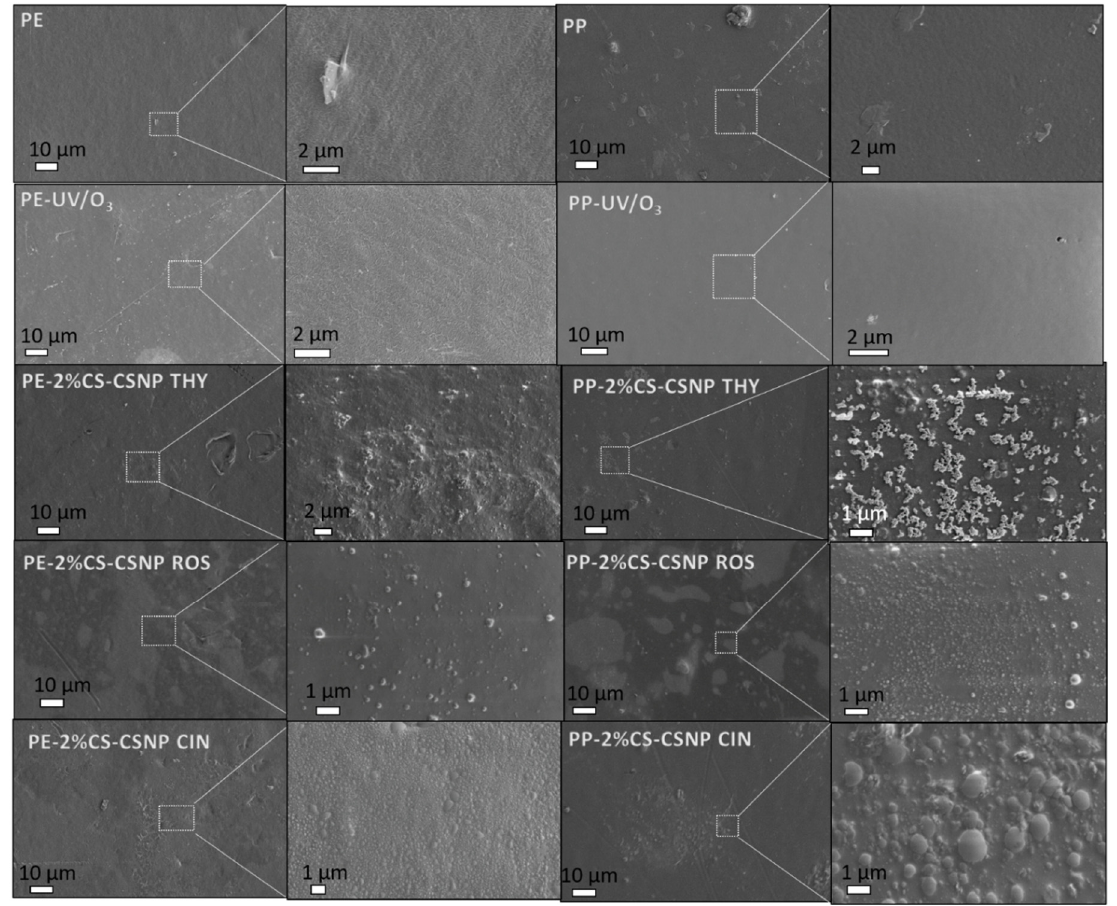
Figure 7. SEM images of functionalized foils.